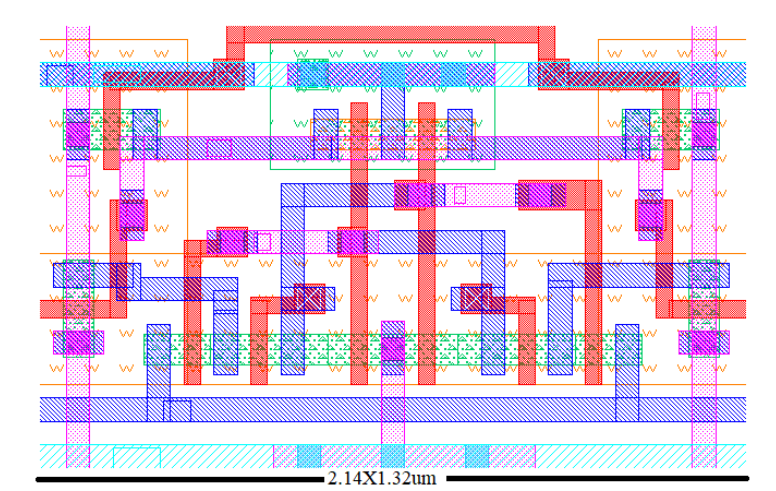
Figure 13. Proposed RS12T SRAM cell